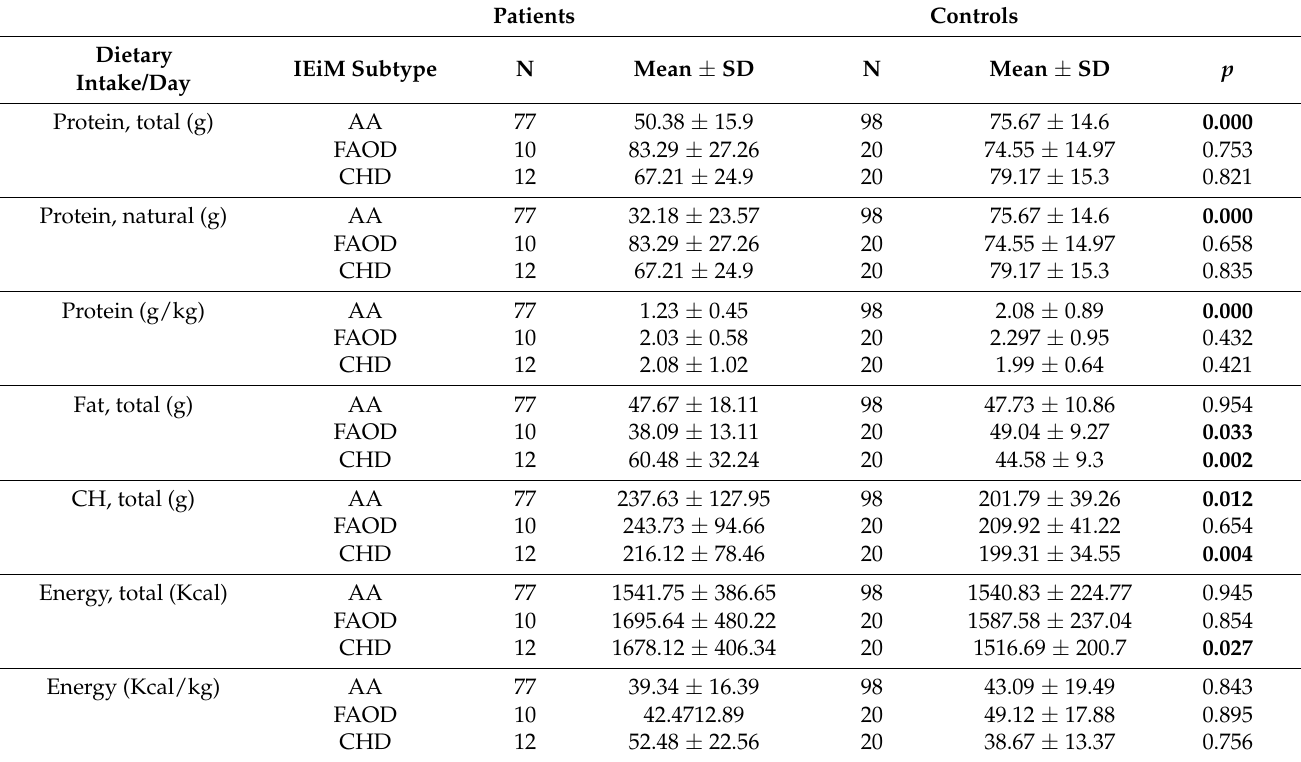
Table 7. Mean dietary intake/day according to IEiM